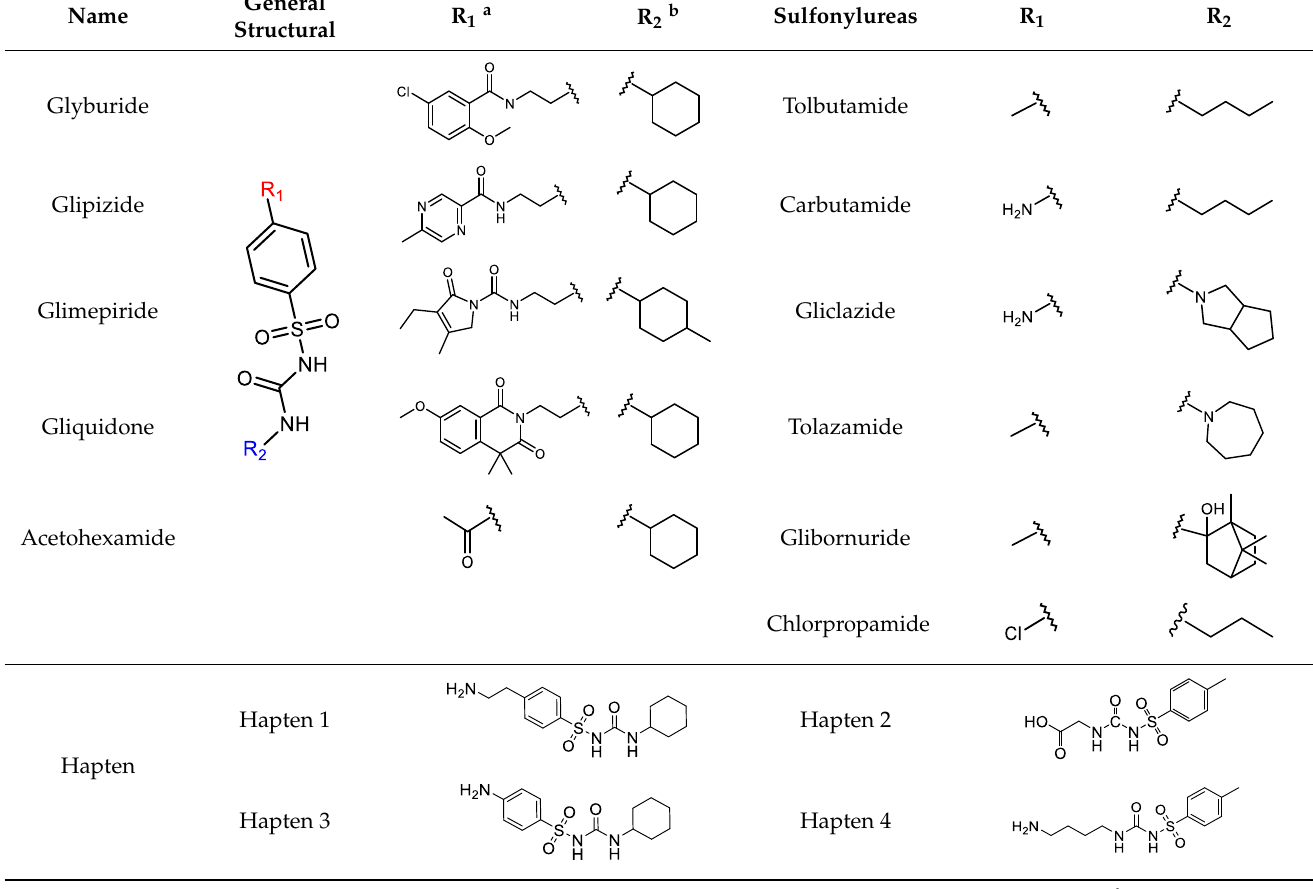
Table 1. Structures and classification of 11 sulfonylureas and the structures of 4 designed hapten.